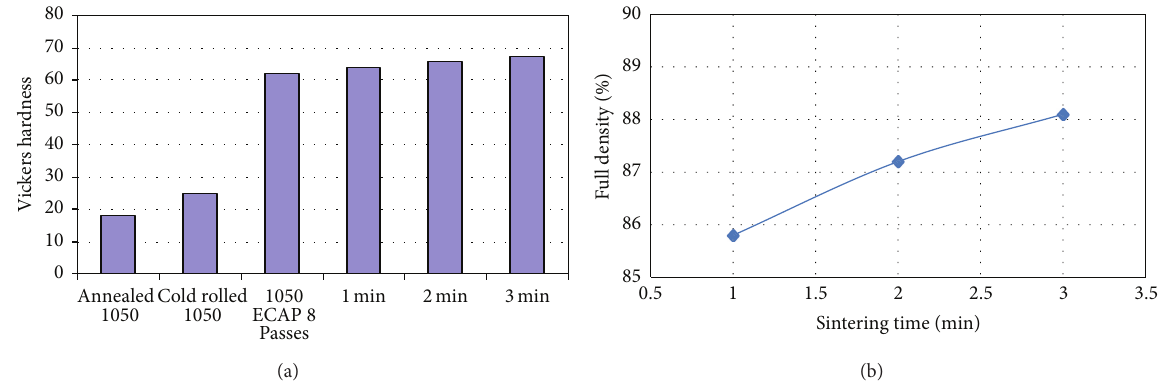
Figure 6: Effect of sintering time on Vickers hardness in (a) as compared to differently processed 1050 Al and percentage of full density in (b) for the powders cryomilled for 7 hours at a sintering temperature of 500 ∘ C.